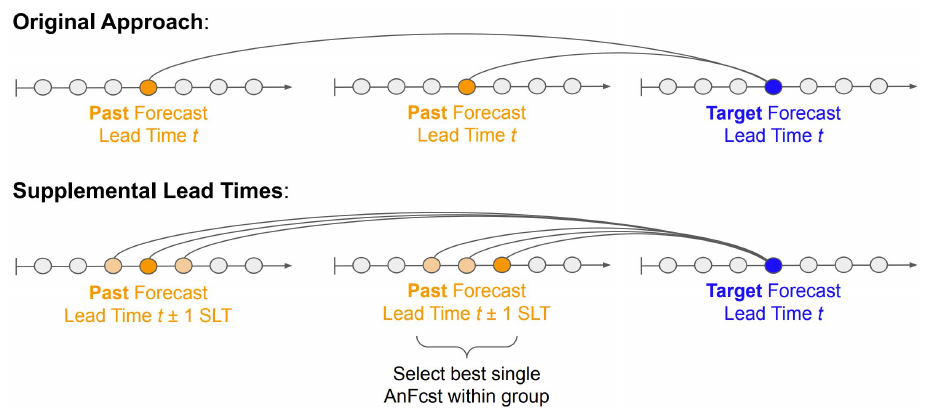
Figure 3. Graphic of the supplemental-lead-time approach (SLT; bottom), compared to the original approach (top). The circles along the arrows represent lead times of an initialization. This example illustrates the analog search at lead time t . For the first past-forecast (PaFcst) initialization, the SLT approach using ± 1 SLTs selects the analog forecast (AnFcst) at lead time t as in the original approach. For the second PaFcst initialization, the SLT approach finds a better AnFcst at lead time t +